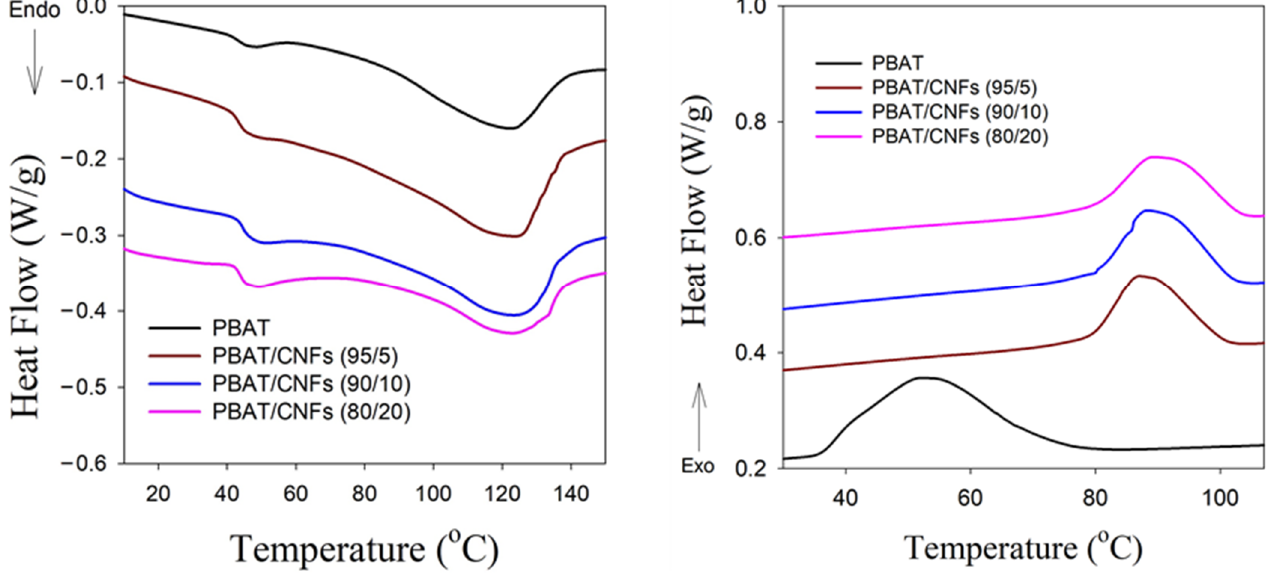
Figure 7. Melting endotherms and cooling exotherms of PBAT as well as PBAT/CNF blends with different concentrations of 5, 10 and 20 wt.% of CNFs.